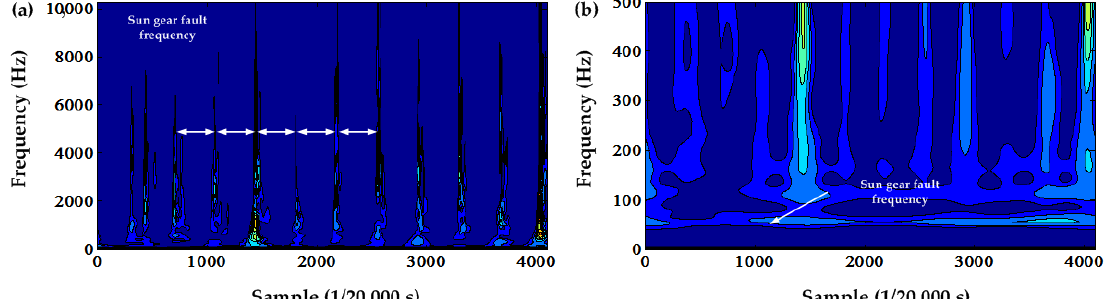
Figure 24. ( a ) Time-frequency contour of the original envelope signal using the S transform; ( b ) local amplification of ( a ).